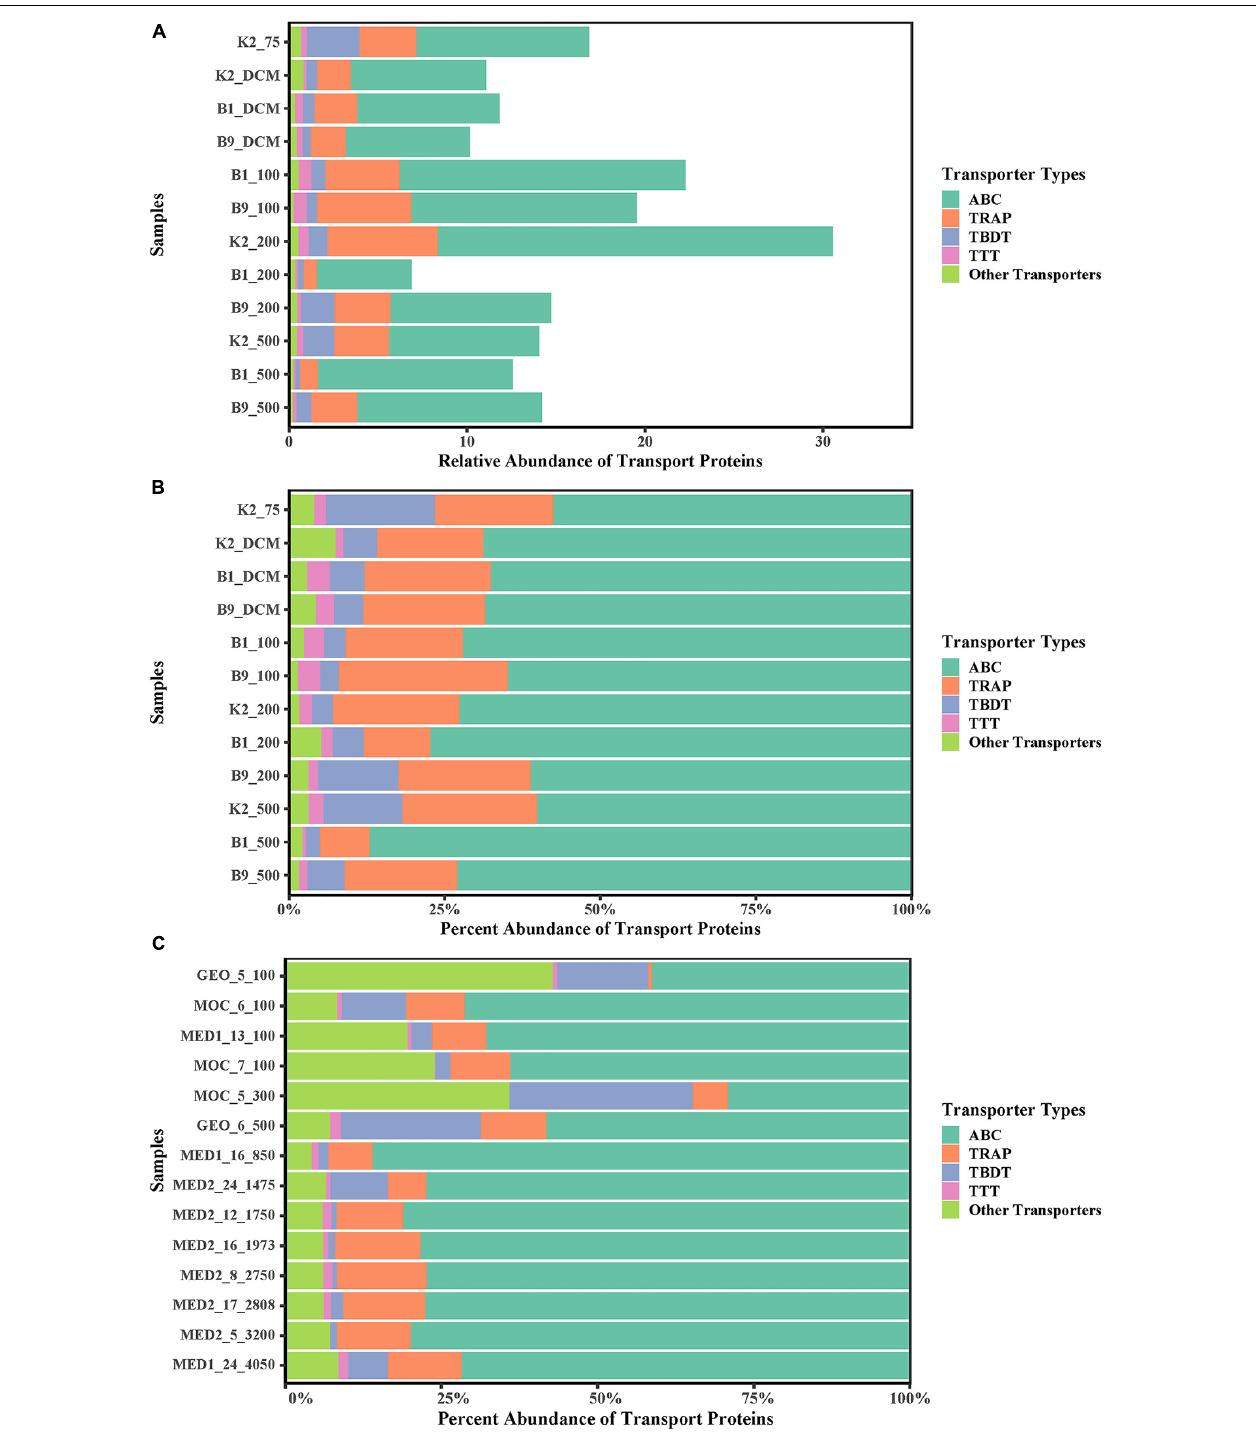
FIGURE 1 | Vertical distribution and relative abundance ratio of ABC, TRAP-T, TTT, and TBDT in all proteins (A) And all transport proteins (B) Of POM solubilization in northwest Pacific Ocean. (C) Vertical distribution and relative abundance ratio of ABC, TRAP-T, TTT, and TBDT in all transporters proteins of DOM in Atlantic Ocean (Bergauer et al., 2018). ABC, ATP-binding cassette; TRAP-T, tripartite ATP-independent; TTT, tripartite tricarboxylate; TBDT, TonB-dependent. Other Transporters, other type of transport proteins. Relative abundances of each transporter type were calculated by summing abundances of all protein assigned to the same type. The percent abundance of transport proteins was calculated by summing the related transport protein abundances and then dividing by the sum of all transport protein abundances.